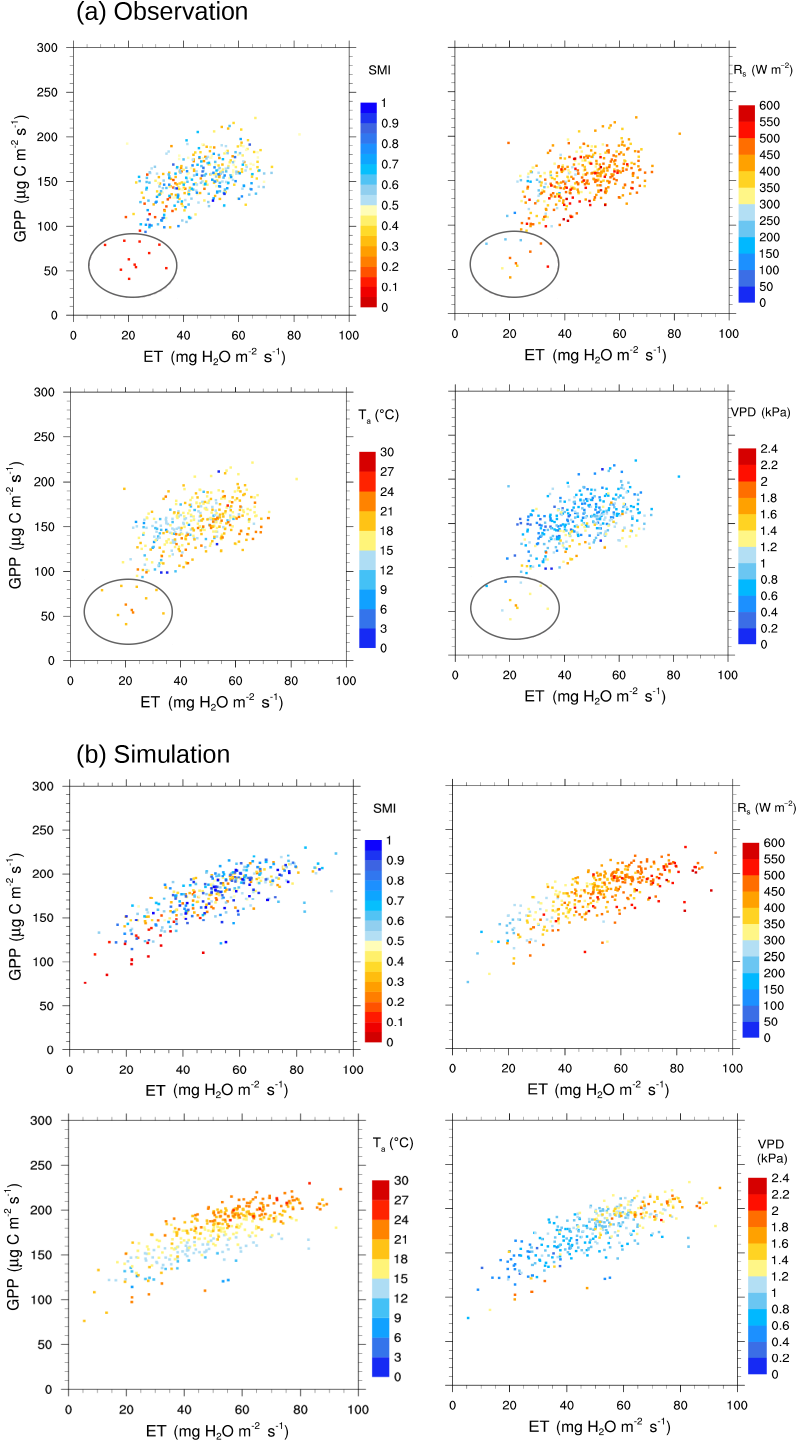
Figure 2. Relationship between the daytime averaged gross primary production (GPP in µgCm − 2 s − 1 ) and evapotranspiration (ET in mg H 2 O m − 2 s − 1 ) at Hyytiälä in the summer months (June, July, August) of the 11-year study period (from 1999 to 2009) from (a) observation and (b) the JSBACH simulation. Data are categorized according to daily mean soil moisture index (SMI), daytime mean incoming shortwave radiation ( R s ), daytime mean air temperature ( T a ), and daytime mean vapour pressure deficit (VPD). In the observation, the group of data under the very dry soil moisture condition showing GPP values lower than other days is marked with a grey